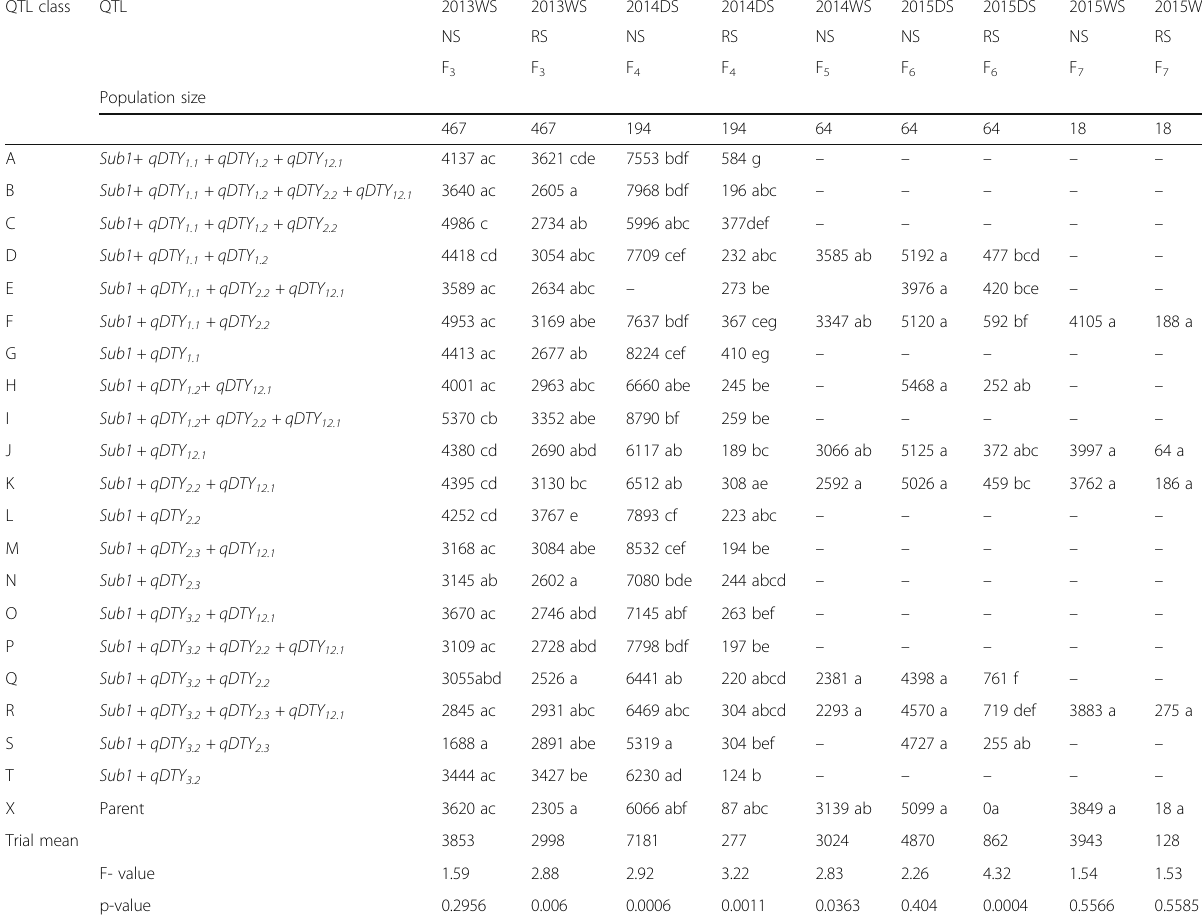
Table 2 Mean comparison of QTL classes of grain yield (kg ha − 1 ) across F 3 to F 7 generations under reproductive-stage drought stress and irrigated non-stress control conditions in IR64-Sub1 background at IRRI, Philippines